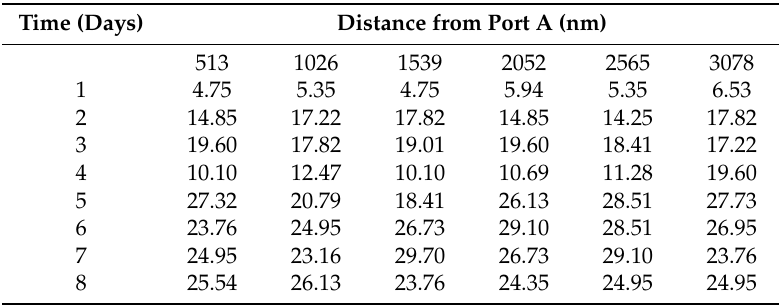
Table A3. Wind speed (in kn) as a function of time and space in